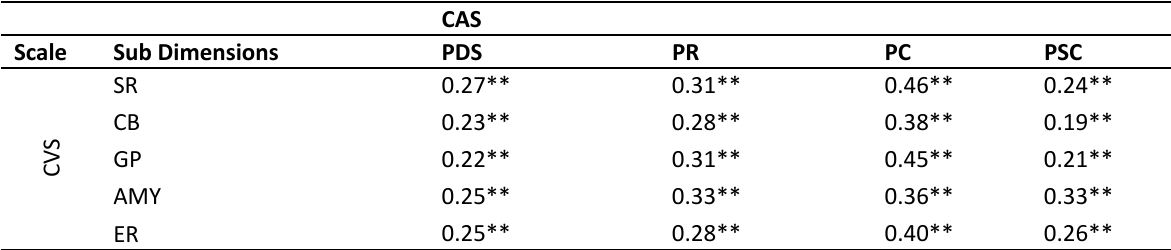
Table 8. Pearson’s Correlation Analysis Results of CVS and CAS sub-dimensions